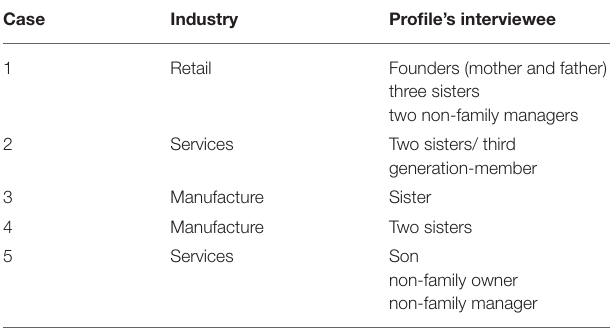
TABLE 1 | Characteristics of the